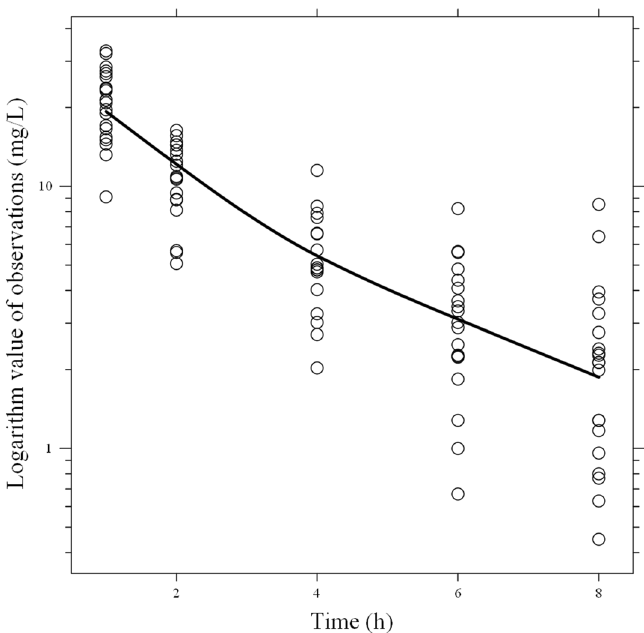
Figure 2. Semi-logarithm plot of doripenem plasma concentrations. The solid line shows the smooth fitting for doripenem plasma concentrations.